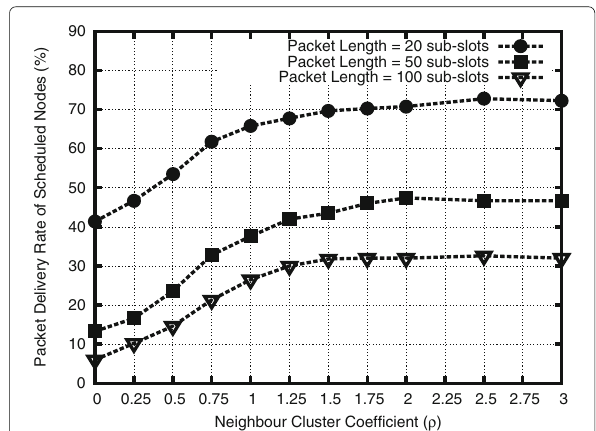
Fig. 6 Packet delivery rate of the scheduled nodes with K = 100, M = 50, CCA thr =-85 dBm, and different packet sizes